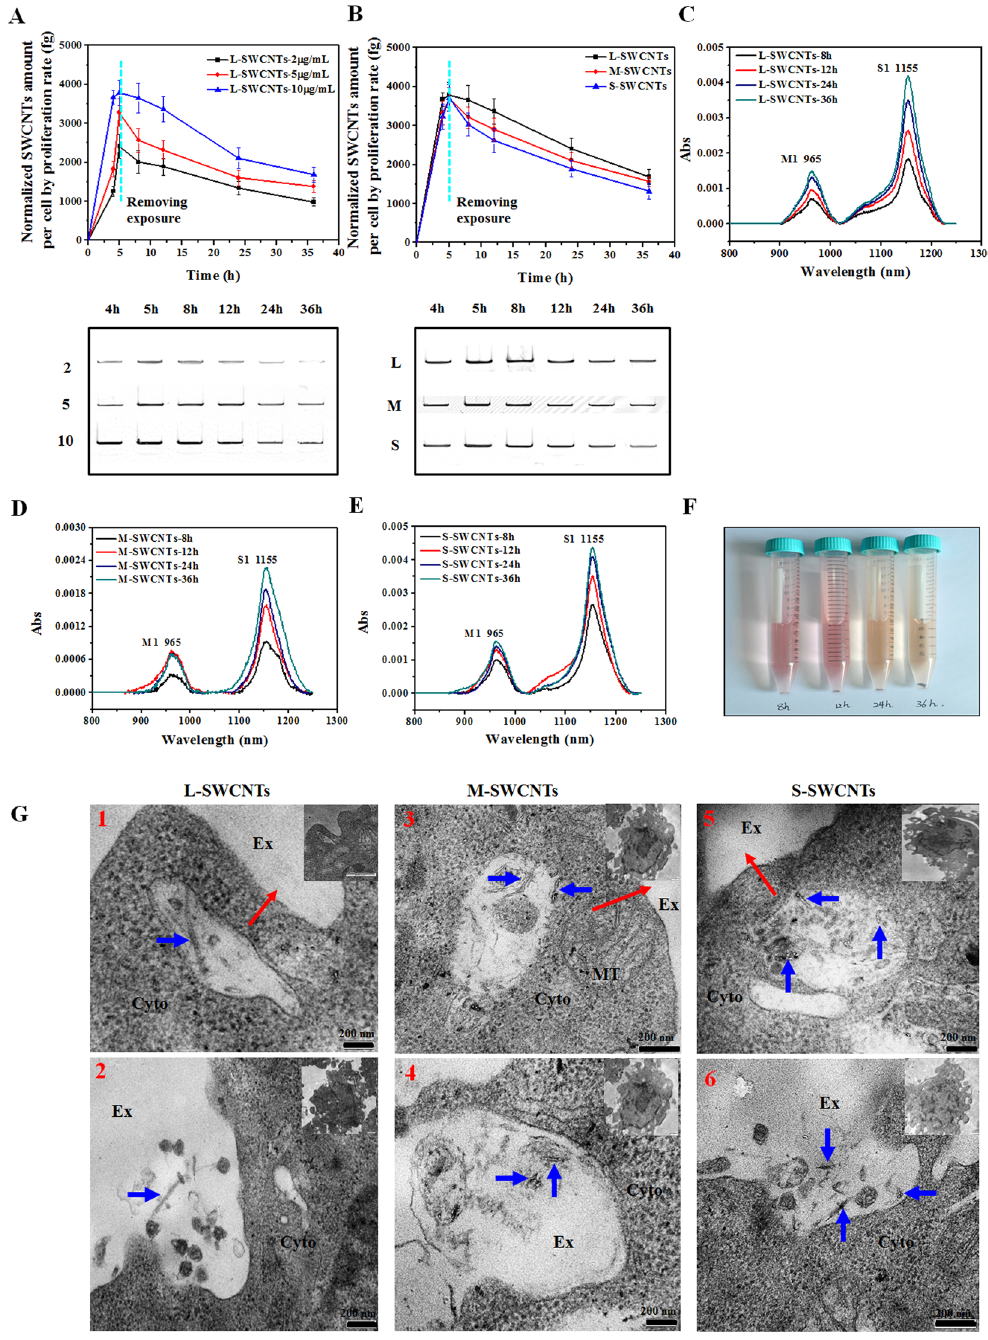
Figure 4. Exocytosis of SWCNTs. ( A ) Normalized measurement of L-SWCNTs by SDS-PAGE gel analyses within cells at different time points after removing exposure solutions at 5 h. ( B ) Normalized measurement of L-, M-, and S-SWCNTs (10 µ g/mL) retained in cells at different time points after removing exposure solutions at 5 h. No statistical significant difference was detected among three groups of SWCNTs (p > 0.05). UV-vis-NIR spectra of the supernatant of L-SWCNTs ( C ), M-SWCNTs ( D ), and S-SWCNTs ( E ) at different time points (8–36 h) after replacing SWCNTs exposure solutions with fresh medium (without SWCNTs). ( F ) L-SWCNTs pellets after replacing the SWCNTs exposure solutions with fresh medium and centrifuging the supernatants collected between 8 and 36 h. ( G ) Typical TEM images showing cellular exocytosis process of L-, M-, and S-SWCNTs (blue arrows). Up panels show typical TEM images of SWCNT-containing vesicles (1, 3, 5) near cell membrane and to be released with complicate lysosomal contents to extracellular space, red arrows indicate the postulated direction of vesicles moving toward cell membrane; down panels show the exocytosed SWCNTs along with substantial lysosomal contents (2, 4, 6). Ex, Cyto, and MT indicates extracellular space, cytoplasm, and mitochondria, respectively. Scale bar is 200 nm for TEM images. For ( A and B ), data are presented as the mean of three independent experiments. Error bars represent the standard error of